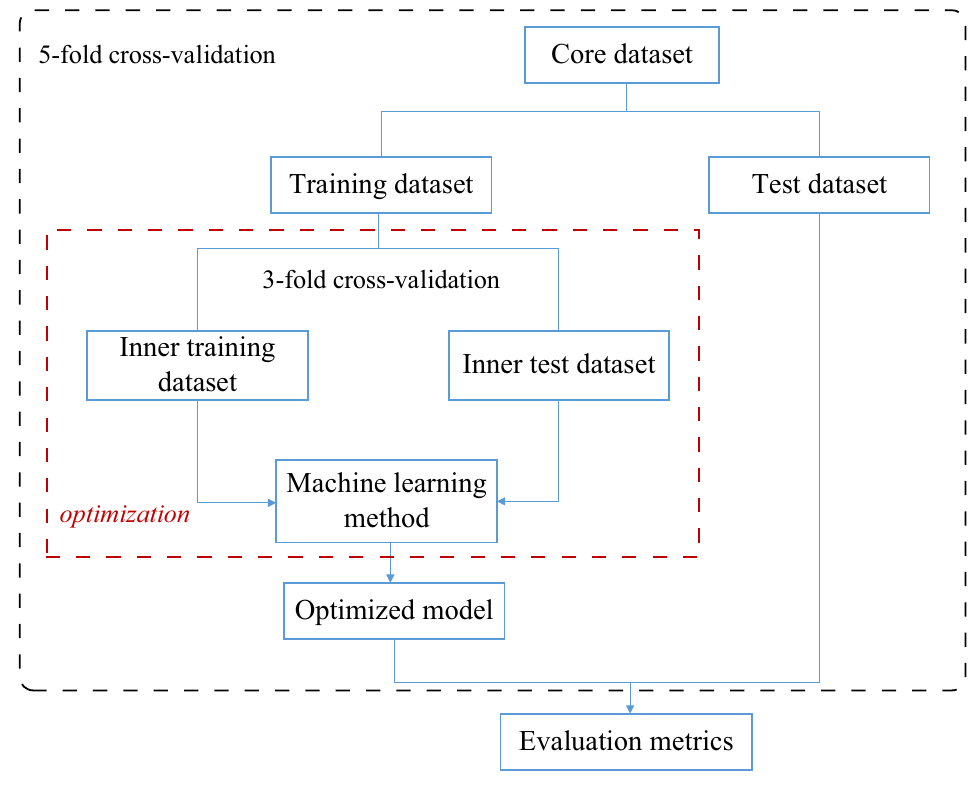
Figure 3. Schematic overview of the framework developed for classifying tumor